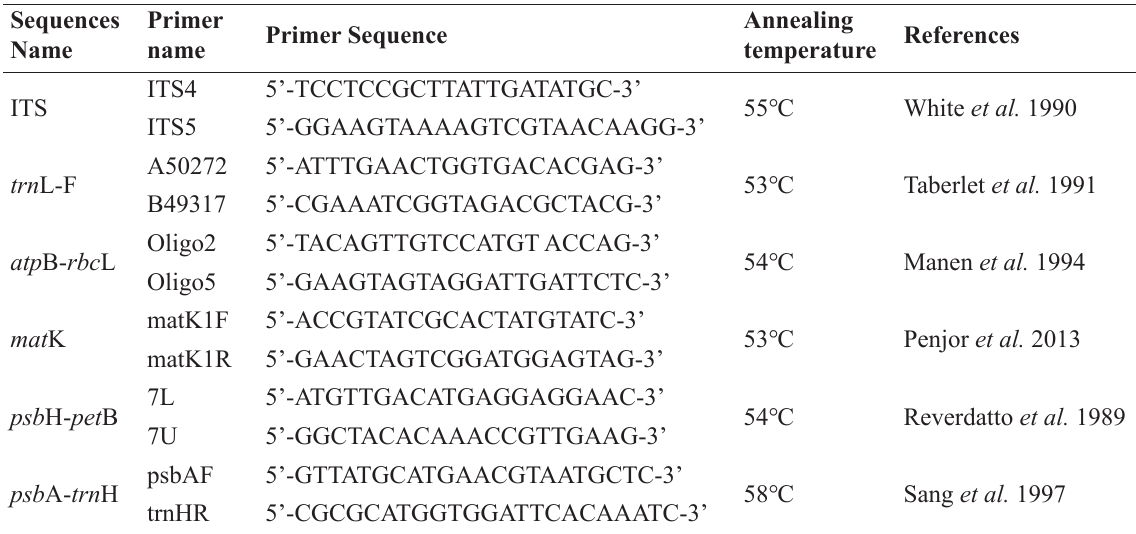
Table 3 . The sequence of all primers in phylogenic